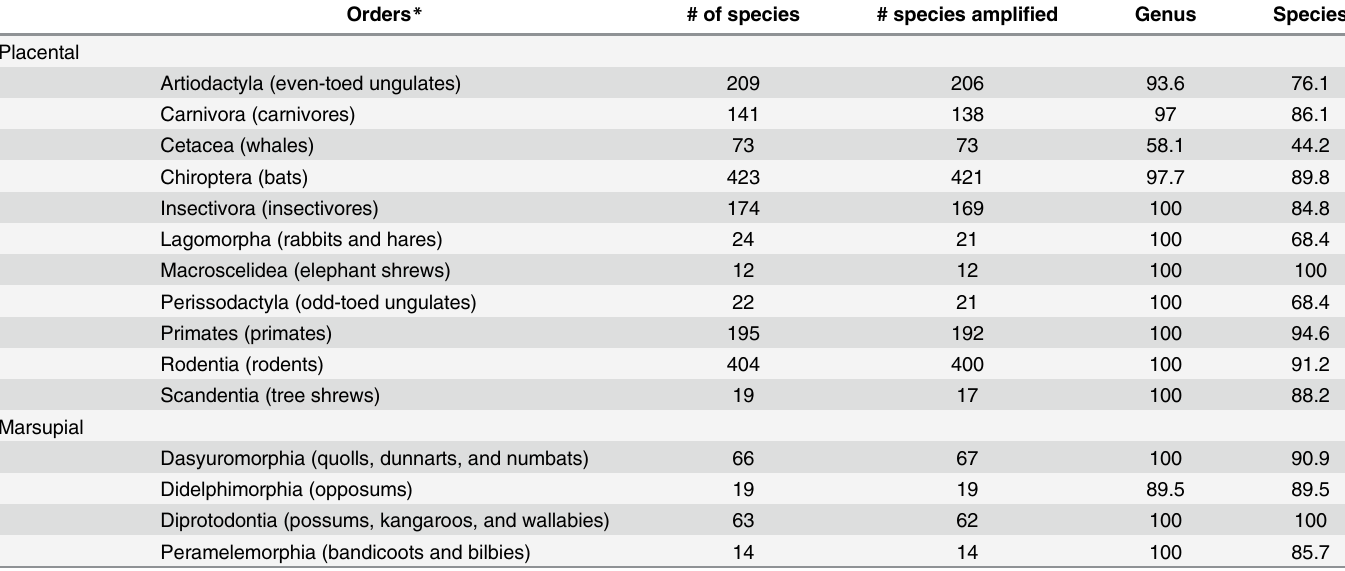
Table 1. Summary of the amplification range and discriminatory power predicted for the mammalian 16S rRNA primers. The table indicates, for each mammalian order, the number of species deposited in NCBI for the 16S rRNA genes, the number of species predicted to be amplified by the universal primers as well as the percentage of genera and species that would carry a unique sequence for this locus (enabling their rigorous identification). Orders